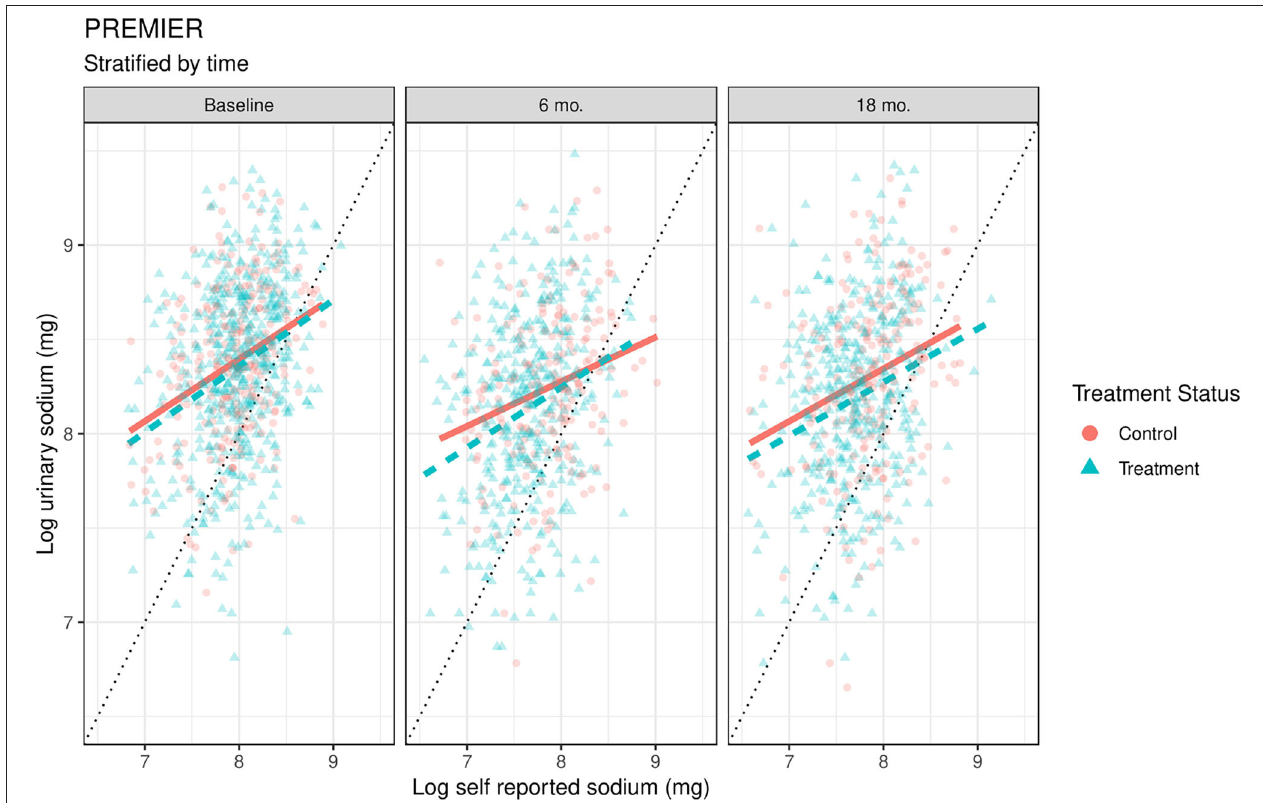
FIGURE 2 | Scatterplots of log urinary sodium vs. log self-reported sodium data time and treatment conditions in PREMIER. The solid orange (control) and dashed blue lines (treatment) are linear smoothers of urinary sodium as a function of self-reported sodium in each treatment condition. 45-degree line represents where urinary sodium equals self-reported sodium. Units are on the natural log scale.